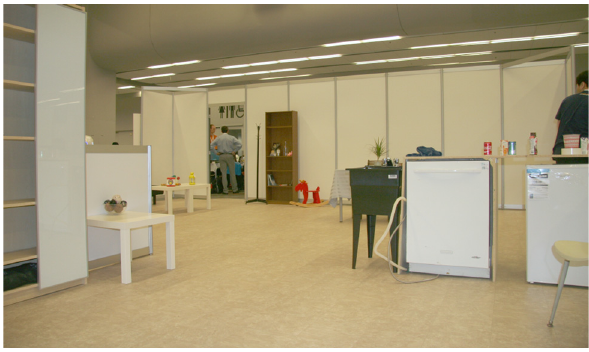
Figure 2: A typical arena used in RoboCup@Home.